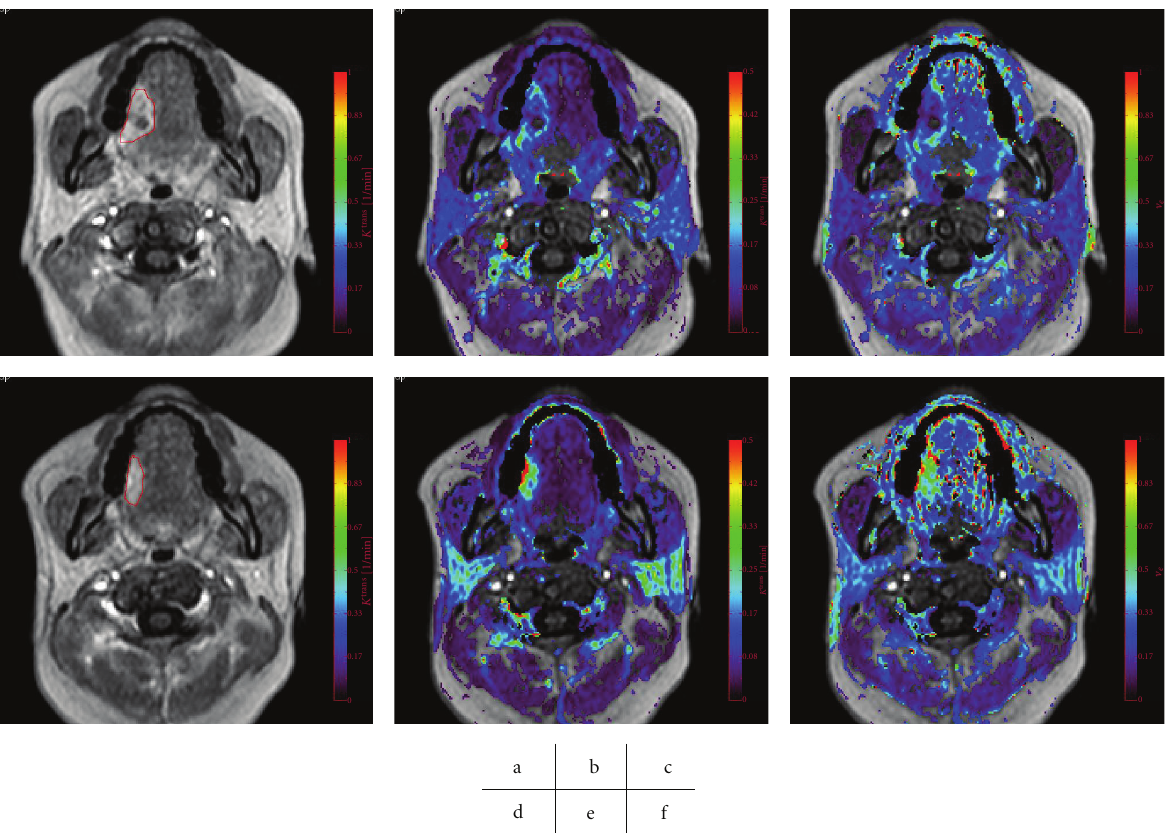
Figure 6: A good tumor response to CRT, with an Ohboshi and Shimosato classification of III. The analyses were performed using a proprietary software program (PRIDE software, Philips Healthcare, Eindhoven, The Netherlands). Pre-CRT (a–c), Gd enhanced T 1 WI (a), T K trans map (e), v K trans map (b), v e map (c), Post-CRT (d–f), Gd enhanced e map (f). The tumor ROIs are delineated in red (a, 1 WI (d),